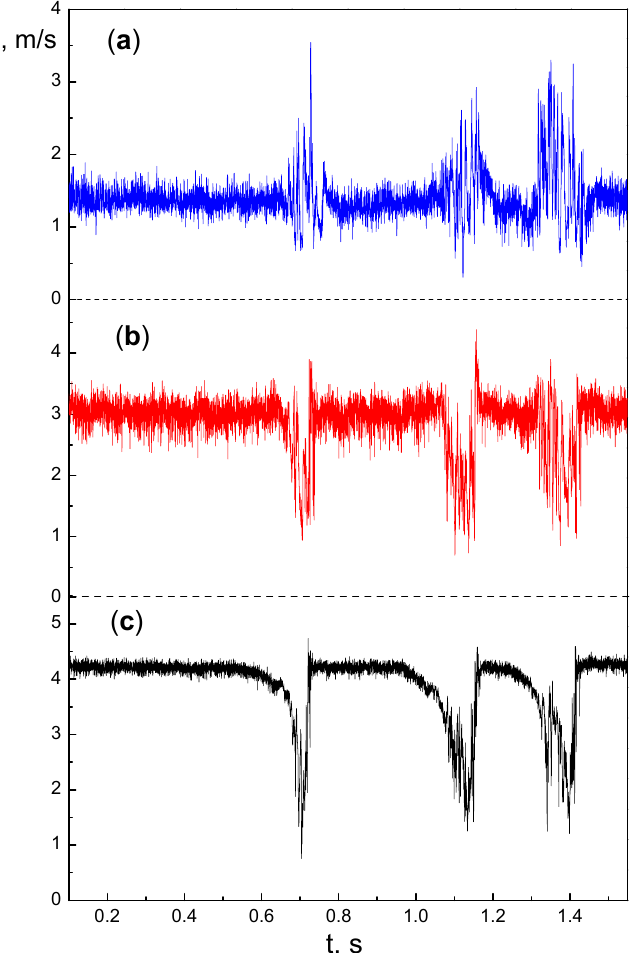
Figure 3. Time evolution of CO 2 longitudinal velocity in the mixing layer at distances r = 4 mm ( a ) and r = 3 mm ( b ) from the axis and on the axis ( r = 0) ( c ) in the x = 60 mm cross-section for Re = 2400.